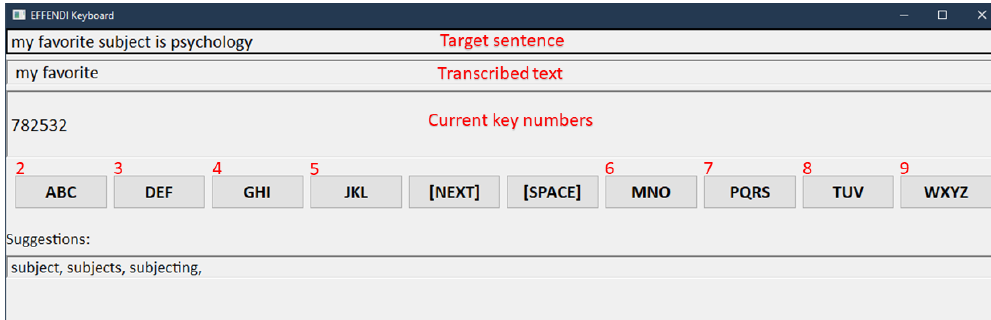
Figure 7. Visual representation of the ambiguous keyboard